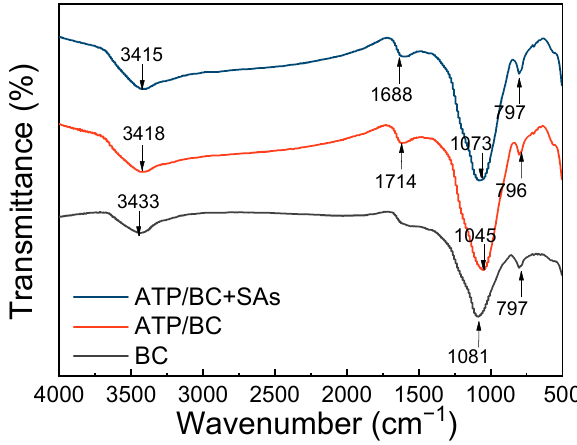
Figure 3. FTIR spectra of ATP, BC, and ATP/BC.